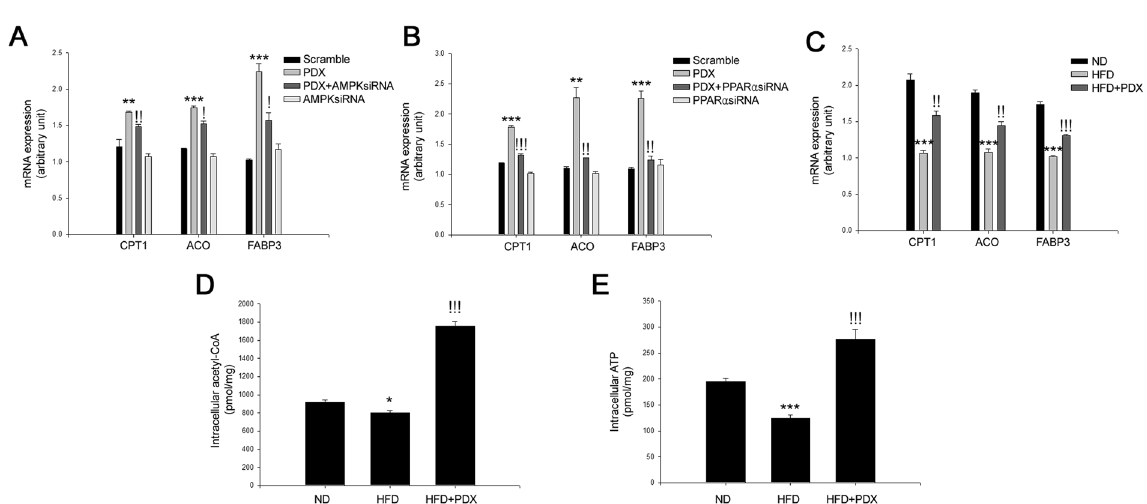
Figure 6. PDX stimulates fatty acid oxidation-associated gene expression. Quantitative real-time PCR analysis of CPT1, ACO, FABP3 mRNA expression in ( A ) AMPK (20 nM) or ( B ) PPAR α siRNA (20 nM)-transfected C2C12 cells treated with PDX (1 μ M) for 24 hr. ( C ) Quantitative real-time PCR analysis of CPT1, ACO, FABP3 mRNA expression in HFD-fed mice treated with PDX. ( D ) Intracellular acetyl-CoA and ( E ) ATP levels in soleus skeletal muscle of HFD-fed mice treated with PDX (1 μ g/mouse/day) for 8 weeks (five animals per treatment group). Means ± SEM were obtained from three separated experiments or five animals. *** P < 0.001 and ** P < 0.01 when compared to the control or the ND treatment. !!! P < 0.001, !! P < 0.01, and ! P < 0.05 when compared to the PDX or the HFD treatment.